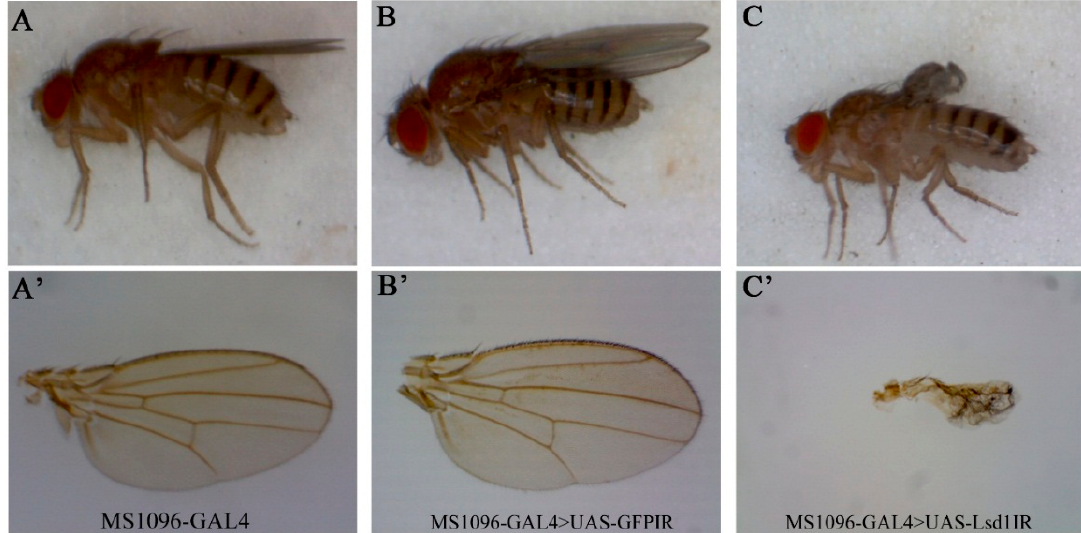
Figure 1. Morphological aberrations in the adult wing of Lsd1 -knockdown flies by